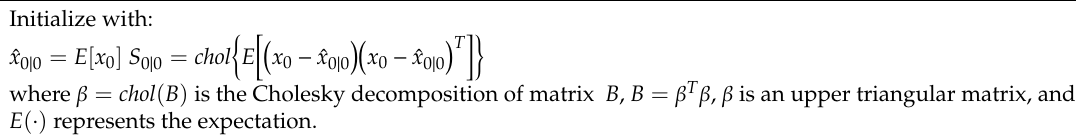
Table A1. SQCKF Algorithm for state